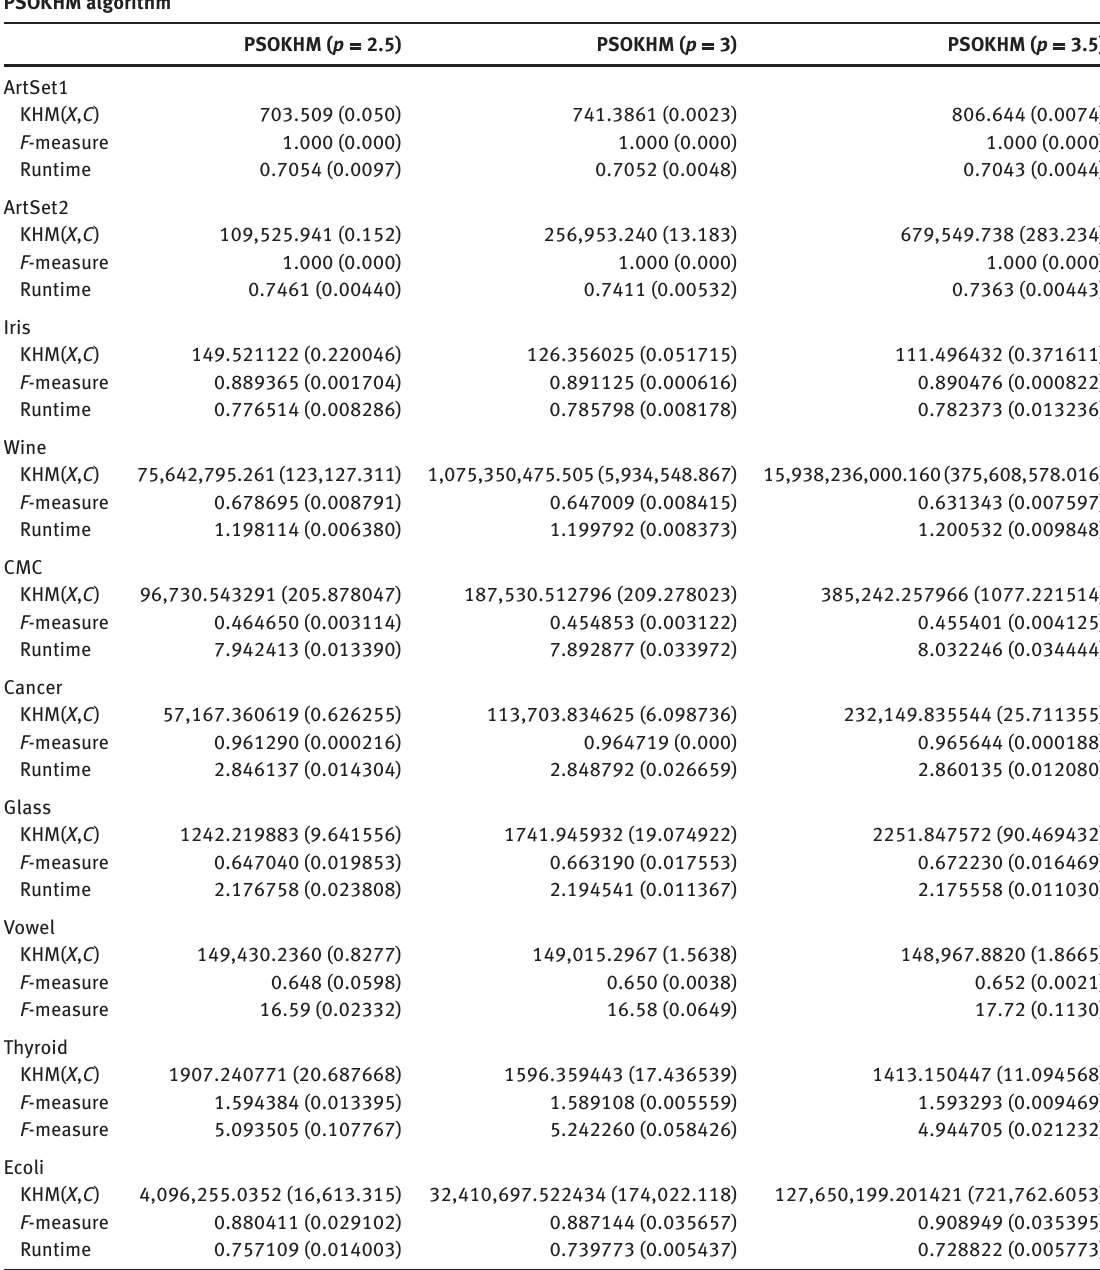
Table 4: Obtained Results for PSOKHM Clustering on Eight Real Data Sets for p = 2.5, p = 3, and p = 3.5 Based on KHM( X , C ), F -Measure, and Runtimes (for 100 Independent